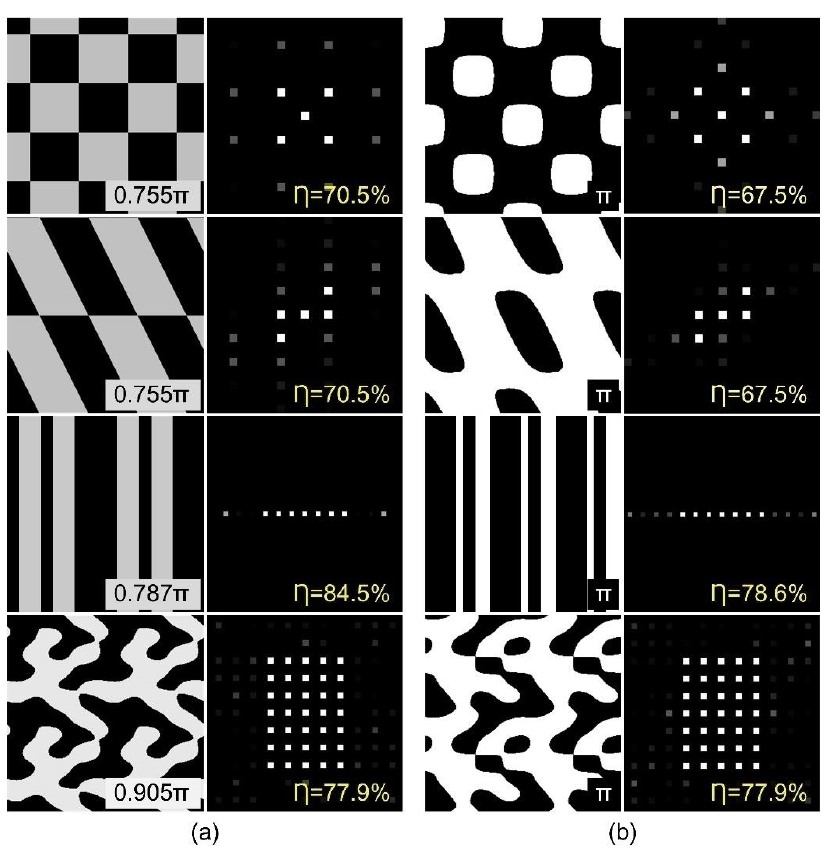
Figure 3. Calculated phase distributions and the reconstructed patterns: ( a ) proposed non 0-π design result, ( b ) conventional 0-π design result.